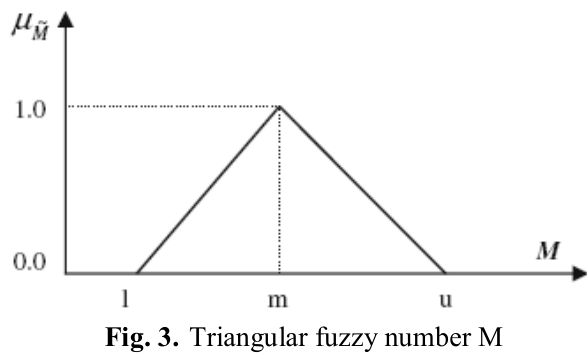
Fig. 3. Triangular fuzzy number